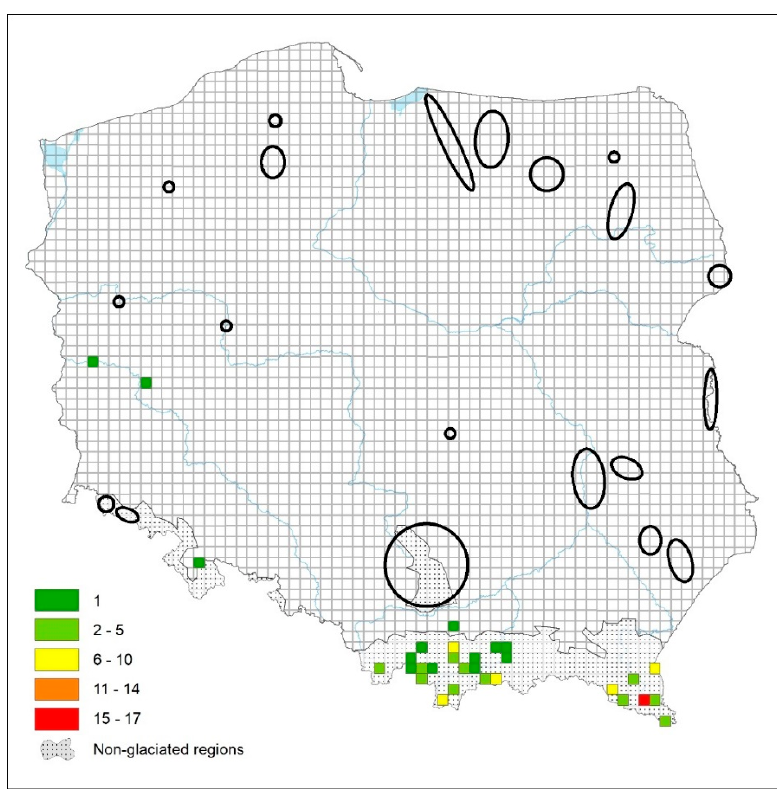
Figure 6. The number of stygobiotic water mites recorded in various squares in Poland. Ellipses (or circles) represent areas in which water mite fauna was studied in various types of surface/subterranean waters but stygobionts were not found. From Dumnicka et al. [57], modified.